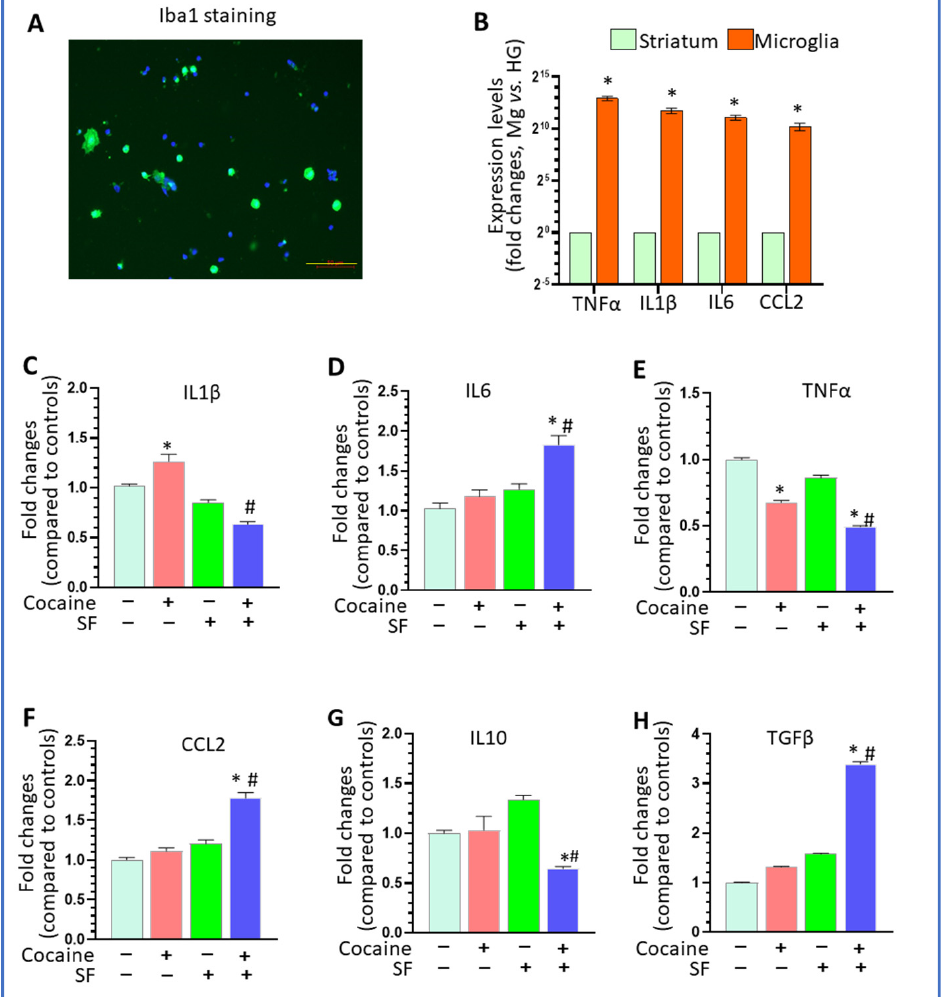
Figure 3. Combined effects of SF and cocaine on microglial immune responses. ( A ) Representative images for Iba1 immunostaining for adult microglia isolated from the striatum (scale bar = 50 µm). ( B ) The enrichment fold of TNF α , IL1 β , IL6, and CCL2 in adult microglia comparing to striatal homogenates. ( C ) Cocaine increased IL1 β levels in purified adult microglia and SF blocked upregula- tion mediated by cocaine (* p < 0.05, vs. sham + saline; # p < 0.05, SF + cocaine vs. sham + cocaine, n = 5). ( D ) Cocaine and chronic SF together significantly increased IL6 levels in purified adult micro- glia (* p < 0.05, vs. sham + saline; # p < 0.05, SF + cocaine vs. sham + cocaine, n = 5). ( E ) Cocaine and SF decreased TNF α levels in purified adult microglia (* p < 0.05, vs. sham + saline; # p < 0.05, SF + cocaine vs. sham + cocaine, n = 5). ( F ) Cocaine and chronic SF together increase SDs CCL2 levels in purified adult microglia (* p < 0.05, vs. sham + saline; # p < 0.05, SF + cocaine vs. sham + cocaine, n = 5). ( G ) Cocaine and SF together decreased IL10 levels in purified adult microglia (* p < 0.05, vs. sham + saline; # p < 0.05, SF + cocaine vs. sham + cocaine, n = 5). ( H ) Cocaine and SF together increased TGF β levels in purified adult microglia (* p < 0.05, vs. sham + saline; # p < 0.05, SF + cocaine vs. sham + cocaine, n = 5).